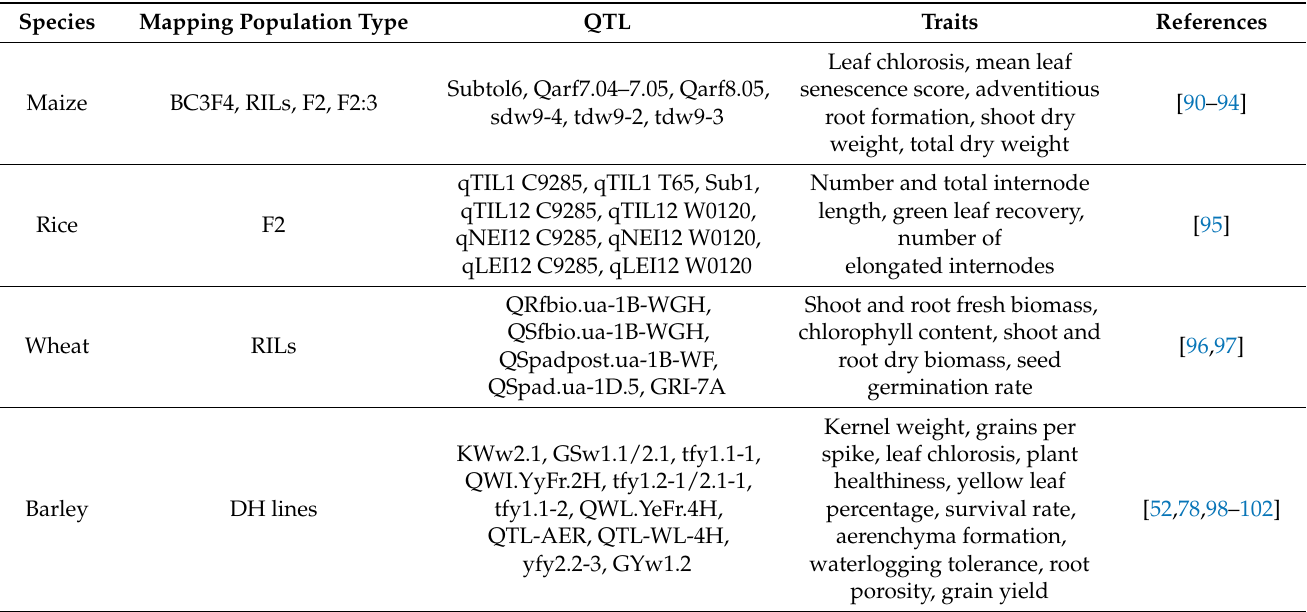
Table 2. List of identified QTLs related with waterlogging tolerance in different